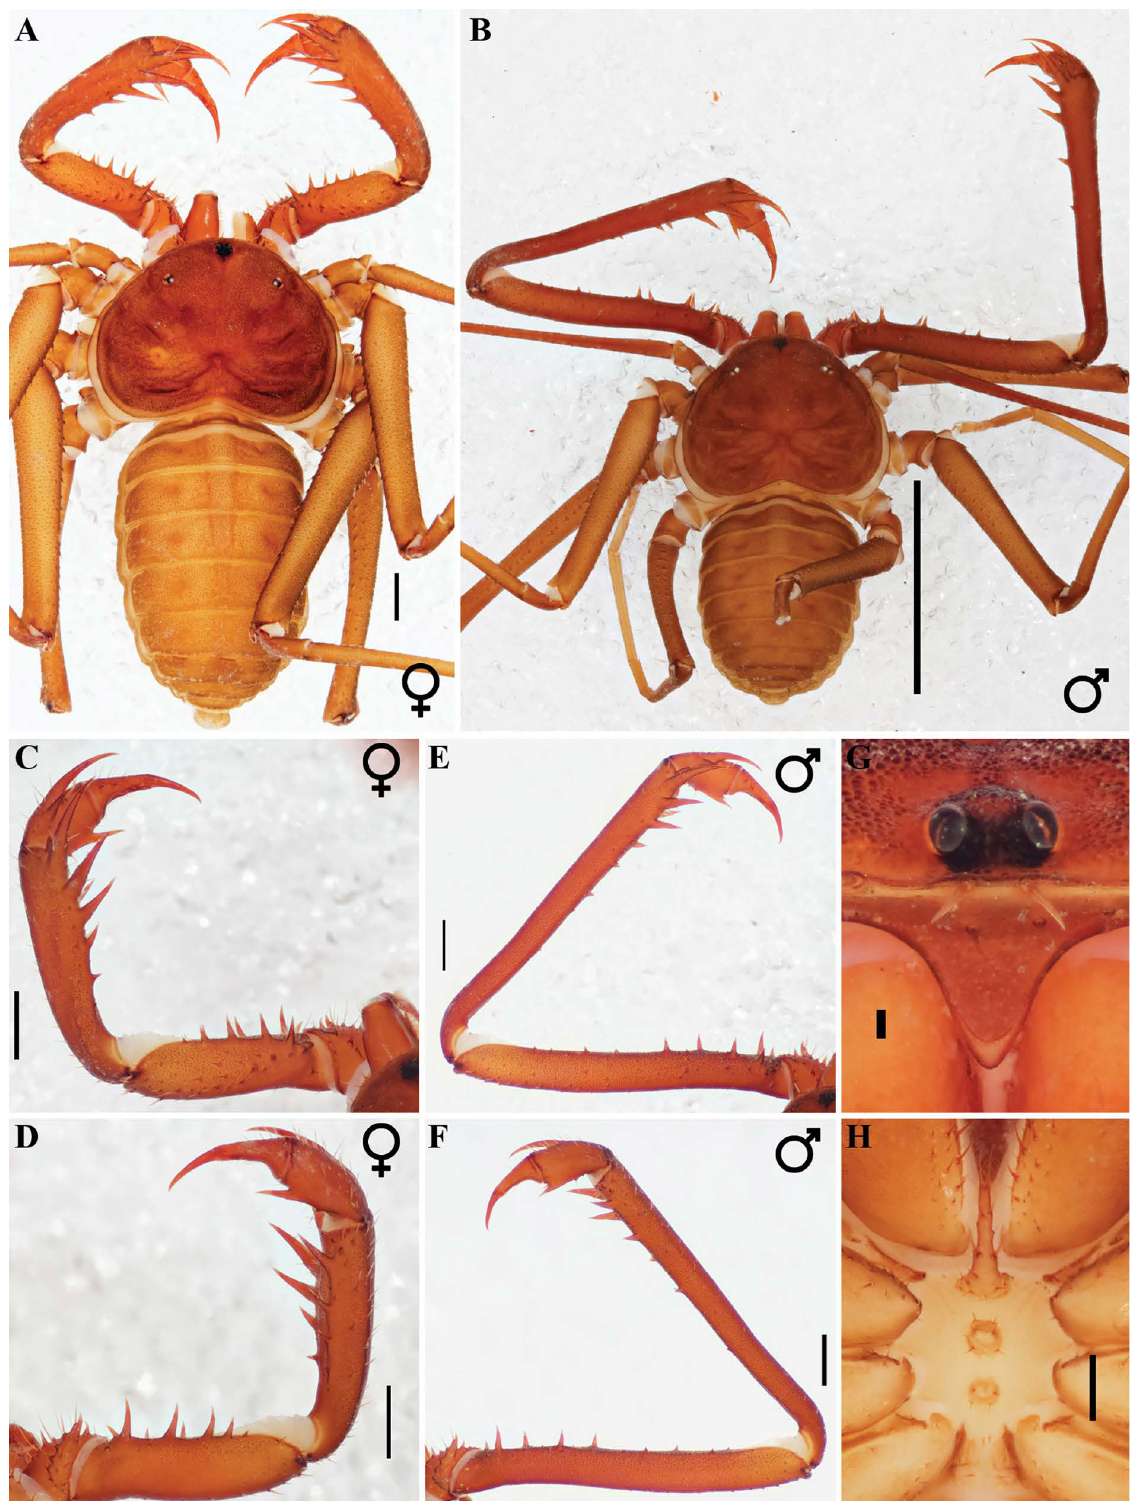
Fig. 48. Charinus brasilianus Weygoldt, 1972, general morphology (MNRJ 9271). A . Female habitus, dorsal view. B . Male habitus, dorsal view. C . Female pedipalp, dorsal view. D . Female pedipalp, ventral view. E . Male pedipalp, dorsal view. F . Male pedipalp, ventral view. G . Frontal process. H . Sternum, ventral view. Scale bars: A, C–F = 1 mm; B = 5 mm; G = 0.1 mm; H = 0.5 mm.